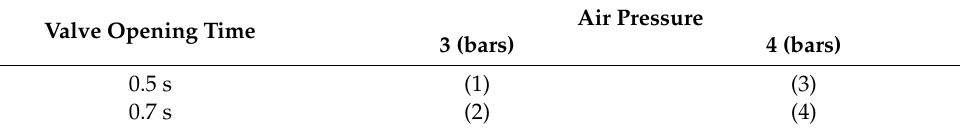
Table 2. Designation of tests depending on the parameters.